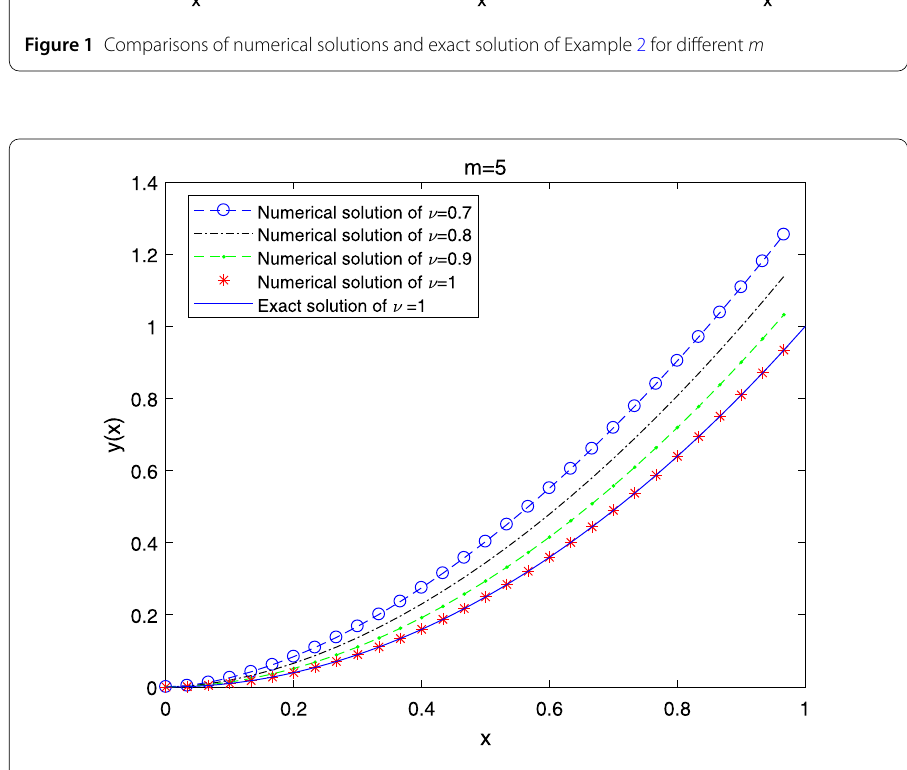
Figure 2 Numerical solutions and exact solution for m = 5, α = ν , with ν = 0.7,0.8,0.9,1